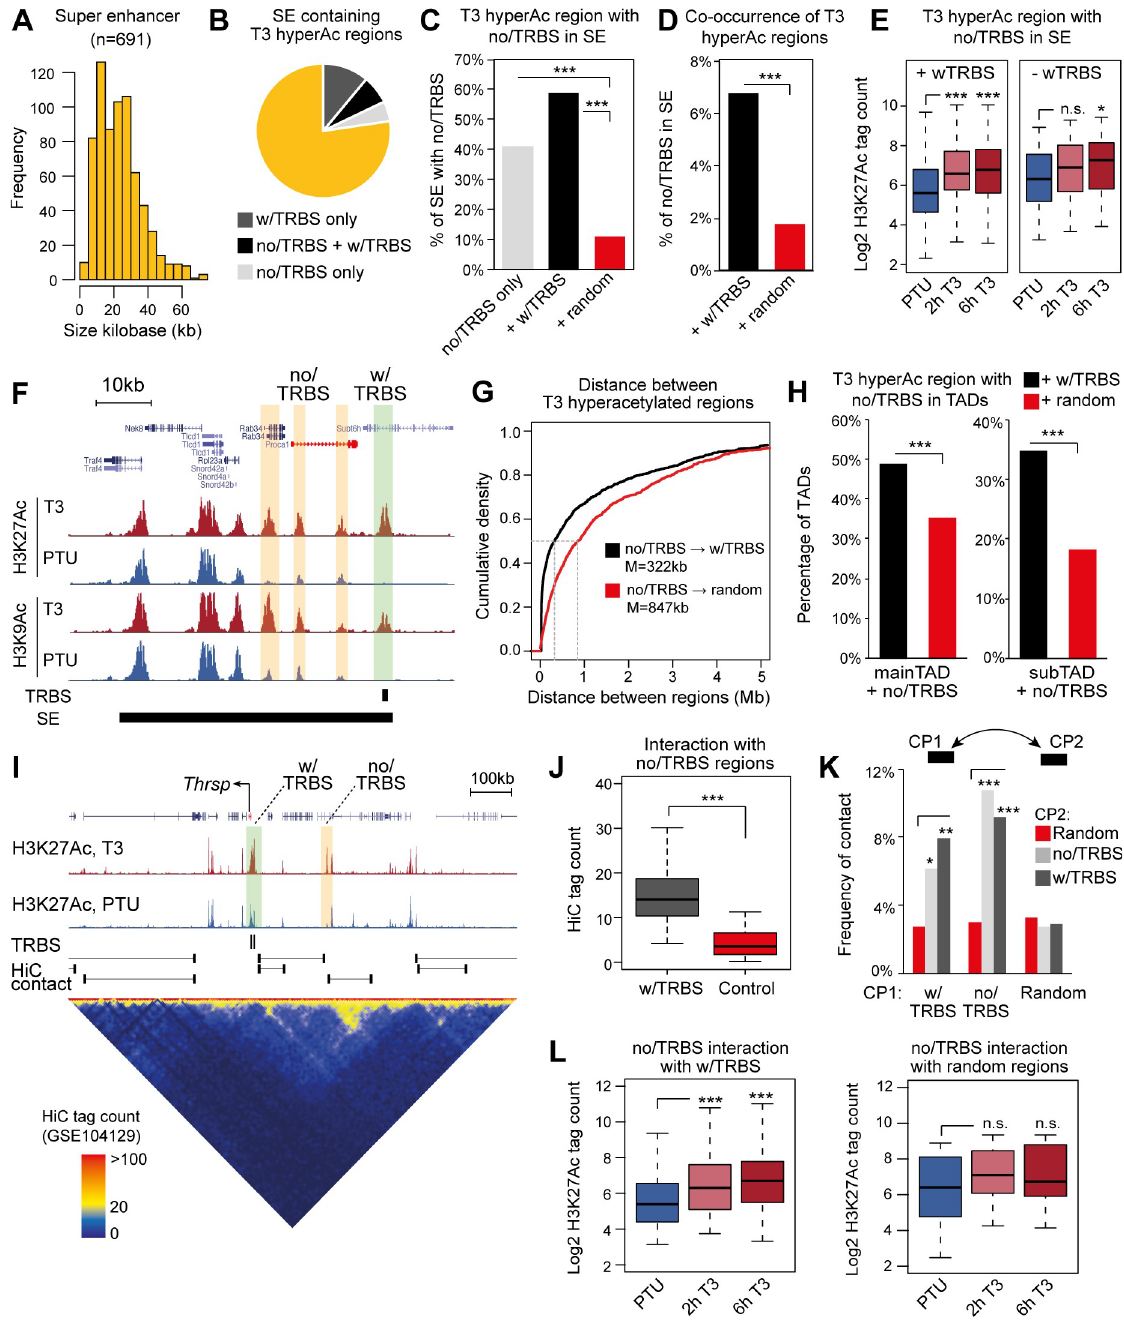
Fig 2. Configuration of hyperacetylated enhancers in SEs and TADs. Hyperacetylated regions were divided into regions with TRBS (w/ TRBS) and without TRBS (no/TRBS). (A) Size distribution of SE in hyperthyroid condition based on H3K27Ac. (B) Fraction of SE containing T3-responsive hyperacetylated enhancers with TRBS and without TRBS. (C) Fraction of SEs containing a hyperacetylated region without a TRBS together with regions containing a TRBS. ��� Fisher’s exact test p < 0.001 using 600 random selected histone acetylated regions. (D) Fraction of hyperacetylated regions without a TRBS that co-occurs in SE with hyperacetylated regions with a TRBS. ��� Fisher’s exact test p < 0.001 using 600 random selected histone acetylated regions. (E) Acute H3K27Ac of regions without a TRBS in a SE with and without hyperacetylated regions containing a TRBS. Statistical difference was determined by a Wilcoxon Signed Rank Test, � p < 0.05, ��� p < 0.001. Non significant is marked by n.s. (F) Example of a SE near the T3-regulated Proca1 gene. (G) Distance between hyperacetylated regions w/TRBS and no/TRBS. The median [M] distance is indicated for no/TRBS to w/TRBS containing regions and no/TRBS to random regions. (H) Fraction of hyperacetylated regions without TRBSs within TADs containing a TRBS. ��� Fisher’s exact test p < 0.001 using 600 random selected histone acetylated regions. (I) Example of HiC contacts in a TAD harbouring the Thrsp gene. (J) HiC tag count of